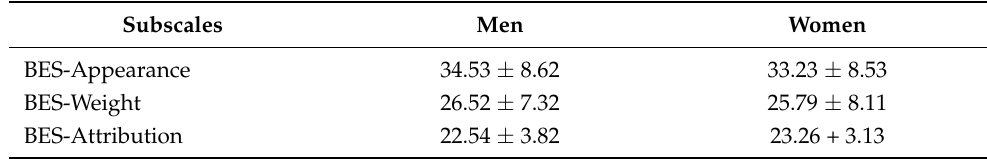
Table 3. Gender differences for the BESSA Scale 1